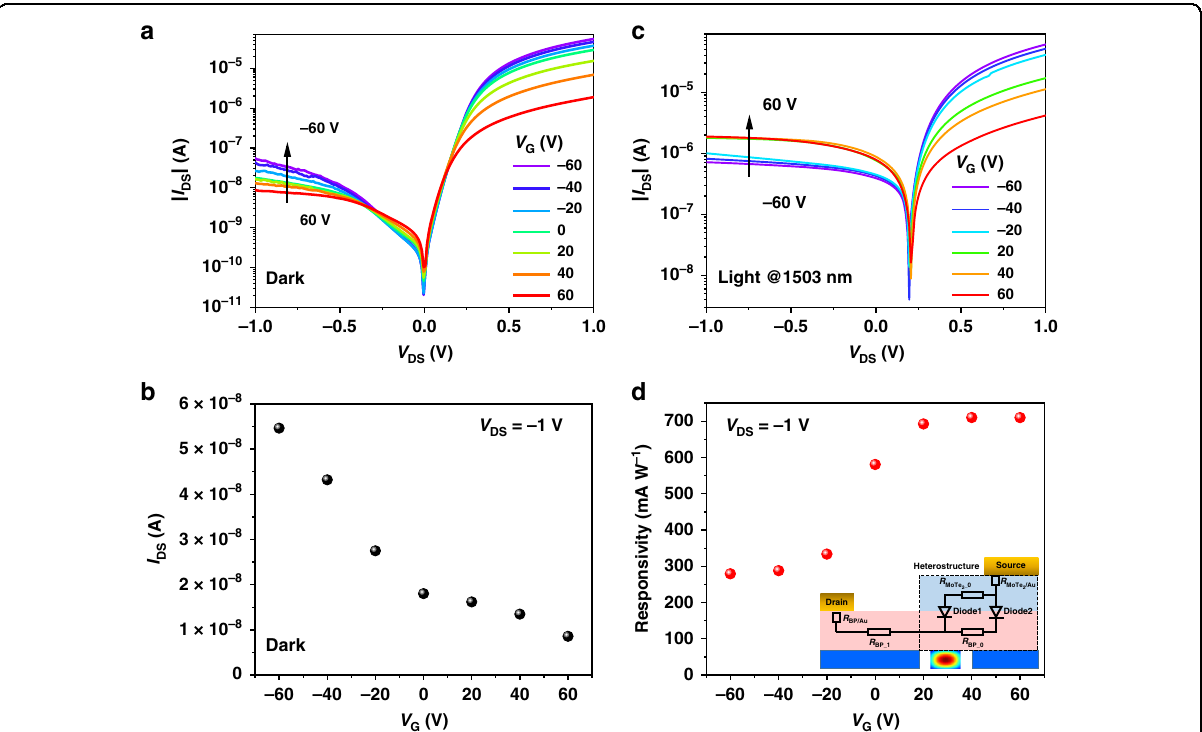
Fig. 4 Tunable optoelectronic characteristics of the waveguide-integrated BP/MoTe 2 heterojunction by electrostatic gating. a Gate tunable I DS – V DS characteristics of the BP/MoTe 2 PN diode in darkness. b Dark currents of the device at V DS = − 1 V as a function of the back gate voltage. c Gate tunable I DS – V DS characteristics of the BP/MoTe 2 PN diode with the optical illumination at the wavelength of 1503 nm. d Intrinsic responsivities of the device at V DS = − 1 V as a function of the back gate voltage. Inset is the cross-section schematics of the simpli fi ed equivalent circuit model of the waveguide-integrated BP/MoTe 2